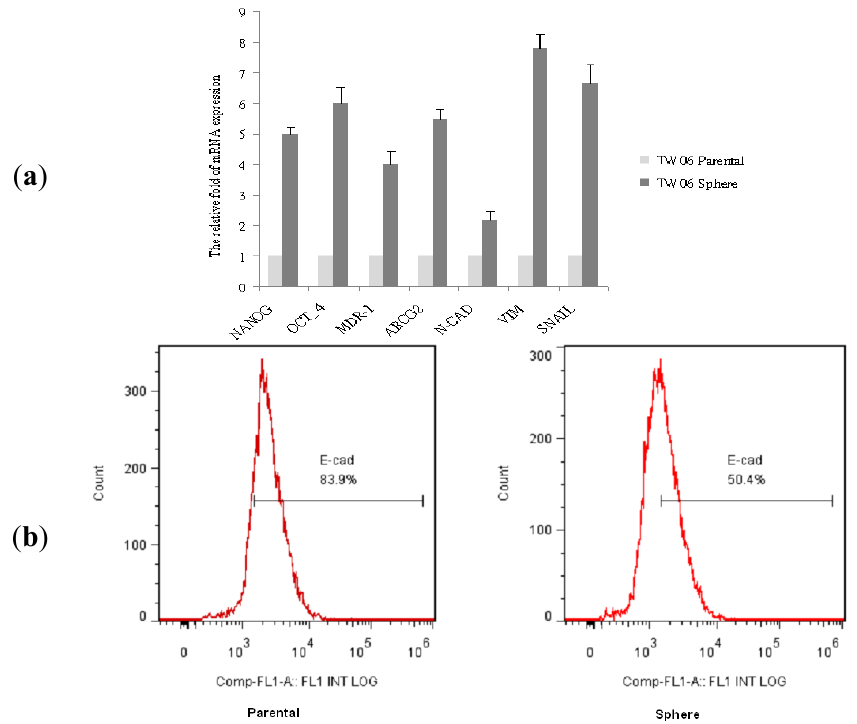
Figure 2. Stemness gene, drug-resistant gene, and EMT marker expression in sphere-derived cells. The expression of ( a ) stemness gene (Oct-4 and Nanog), drug-resistant gene (MDR and ABCG2), and EMT marker (N-cad, vimentin, and snail) mRNA was significantly higher in the TW06 sphere-derived cells than in the parental cells; ( b ) The TW06 sphere-derived cells displayed lower E-cad expression than the parental cells